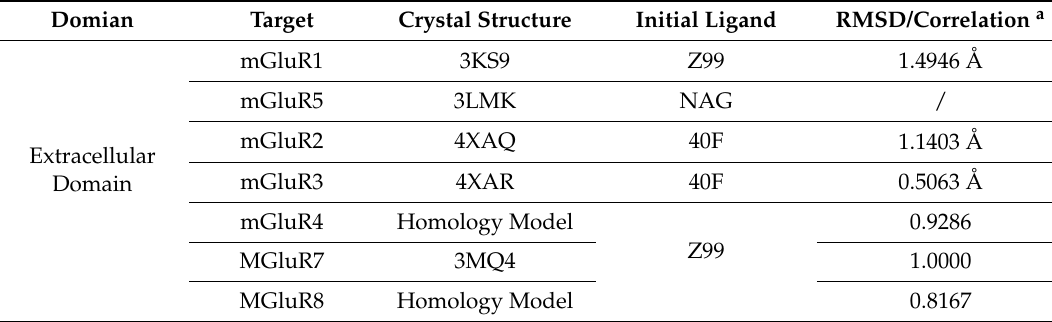
Table 8. Identification and evaluation of the orthosteric active